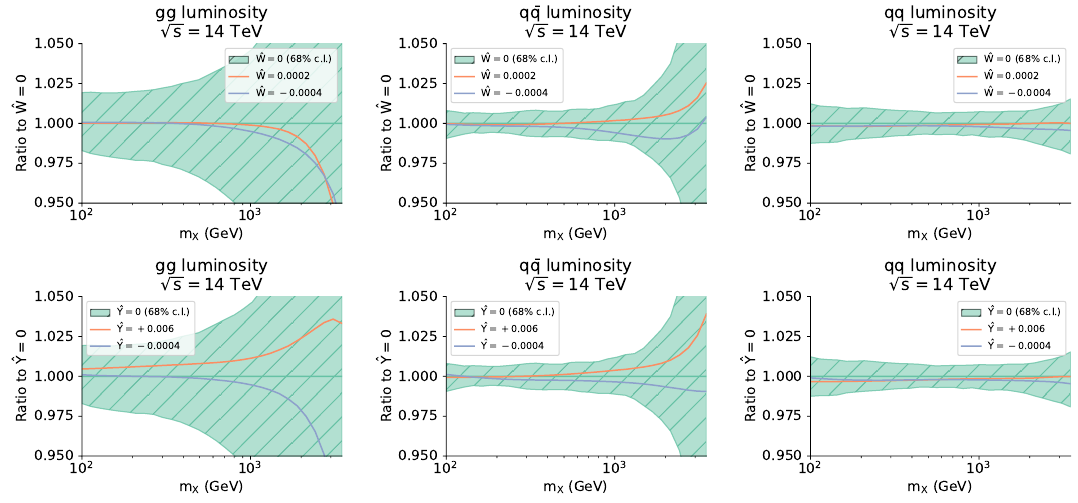
Figure 6 . Comparison between the SM PDF luminosities with their SMEFT counterparts, dis- played as ratios to the central value of the SM luminosities, for representative values of the ˆ W (upper) and ˆ Y (lower panel) parameters. The values of ˆ W and ˆ Y are chosen to be close to the upper and lower limits of the 68% CL intervals reported in table